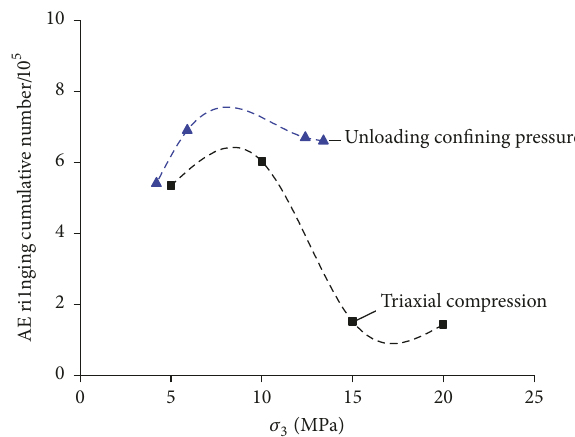
Figure 11: The trend line of AE accumulative ringing of rock specimens on the breaking